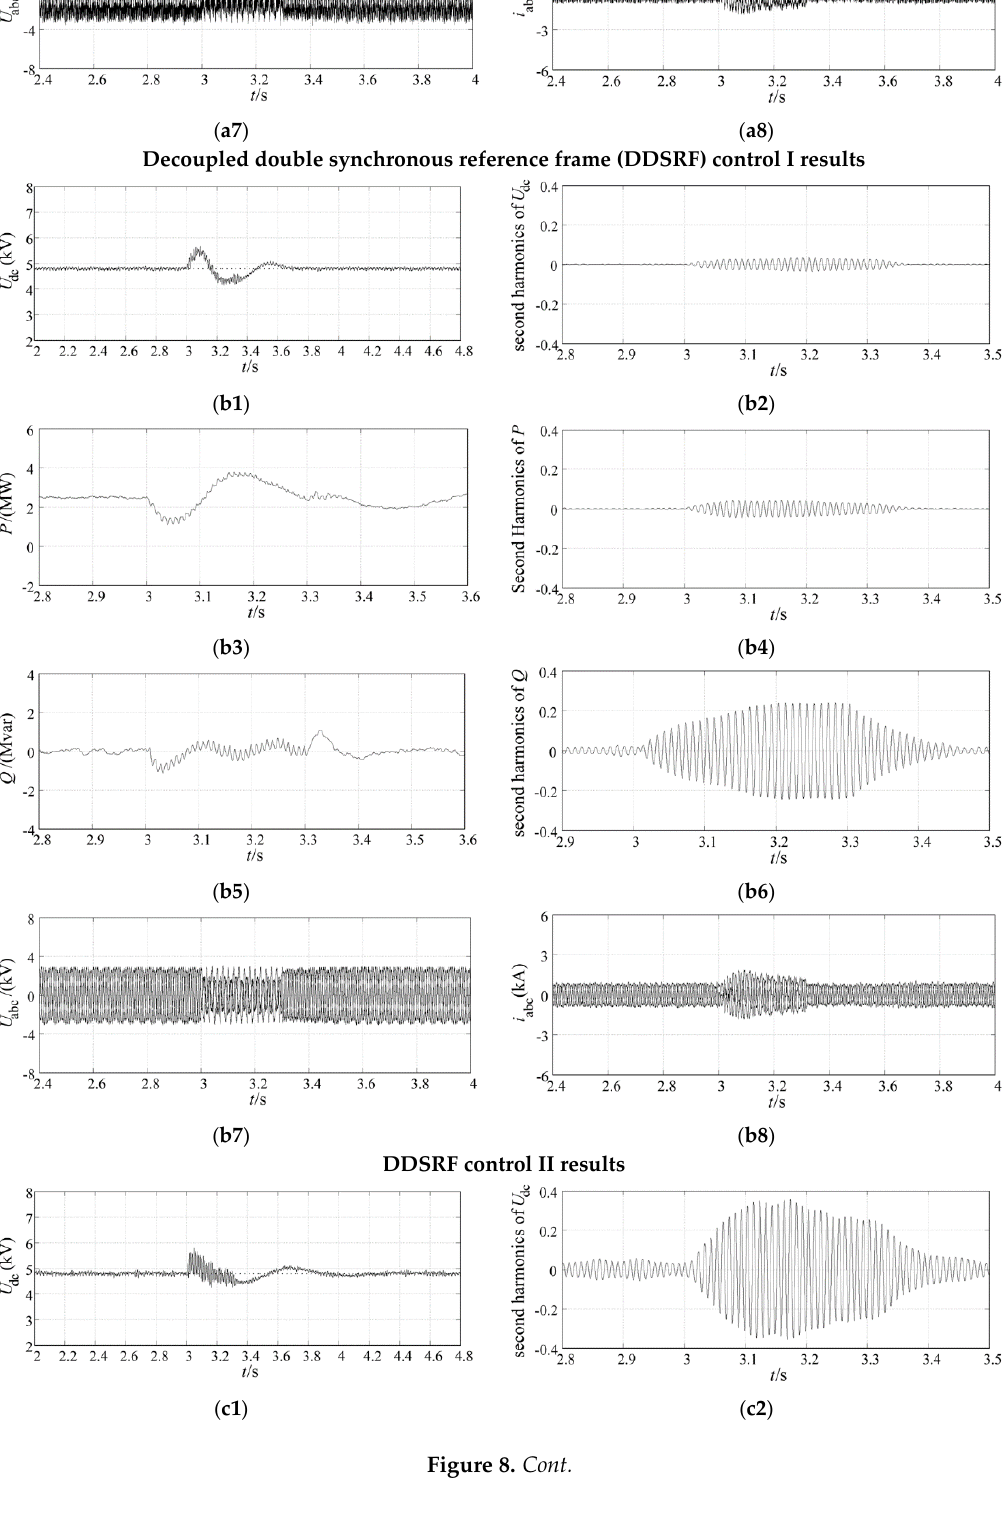
Figure 8. Cont. Figure 8.